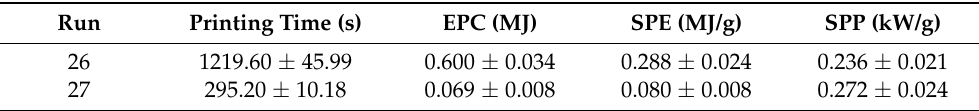
Table 10. Average and standard deviation values of measured responses for printing time, EPC, SPE, and SPP, for the confirmation